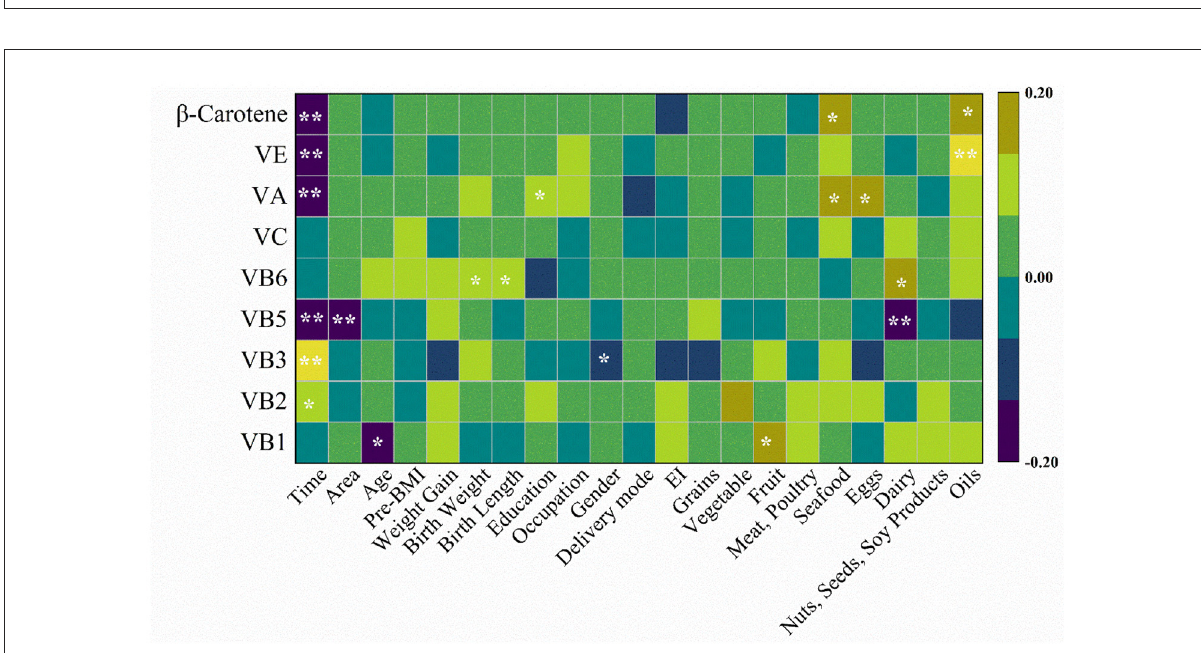
FIGURE2 The HM vitamins contents change with lactation